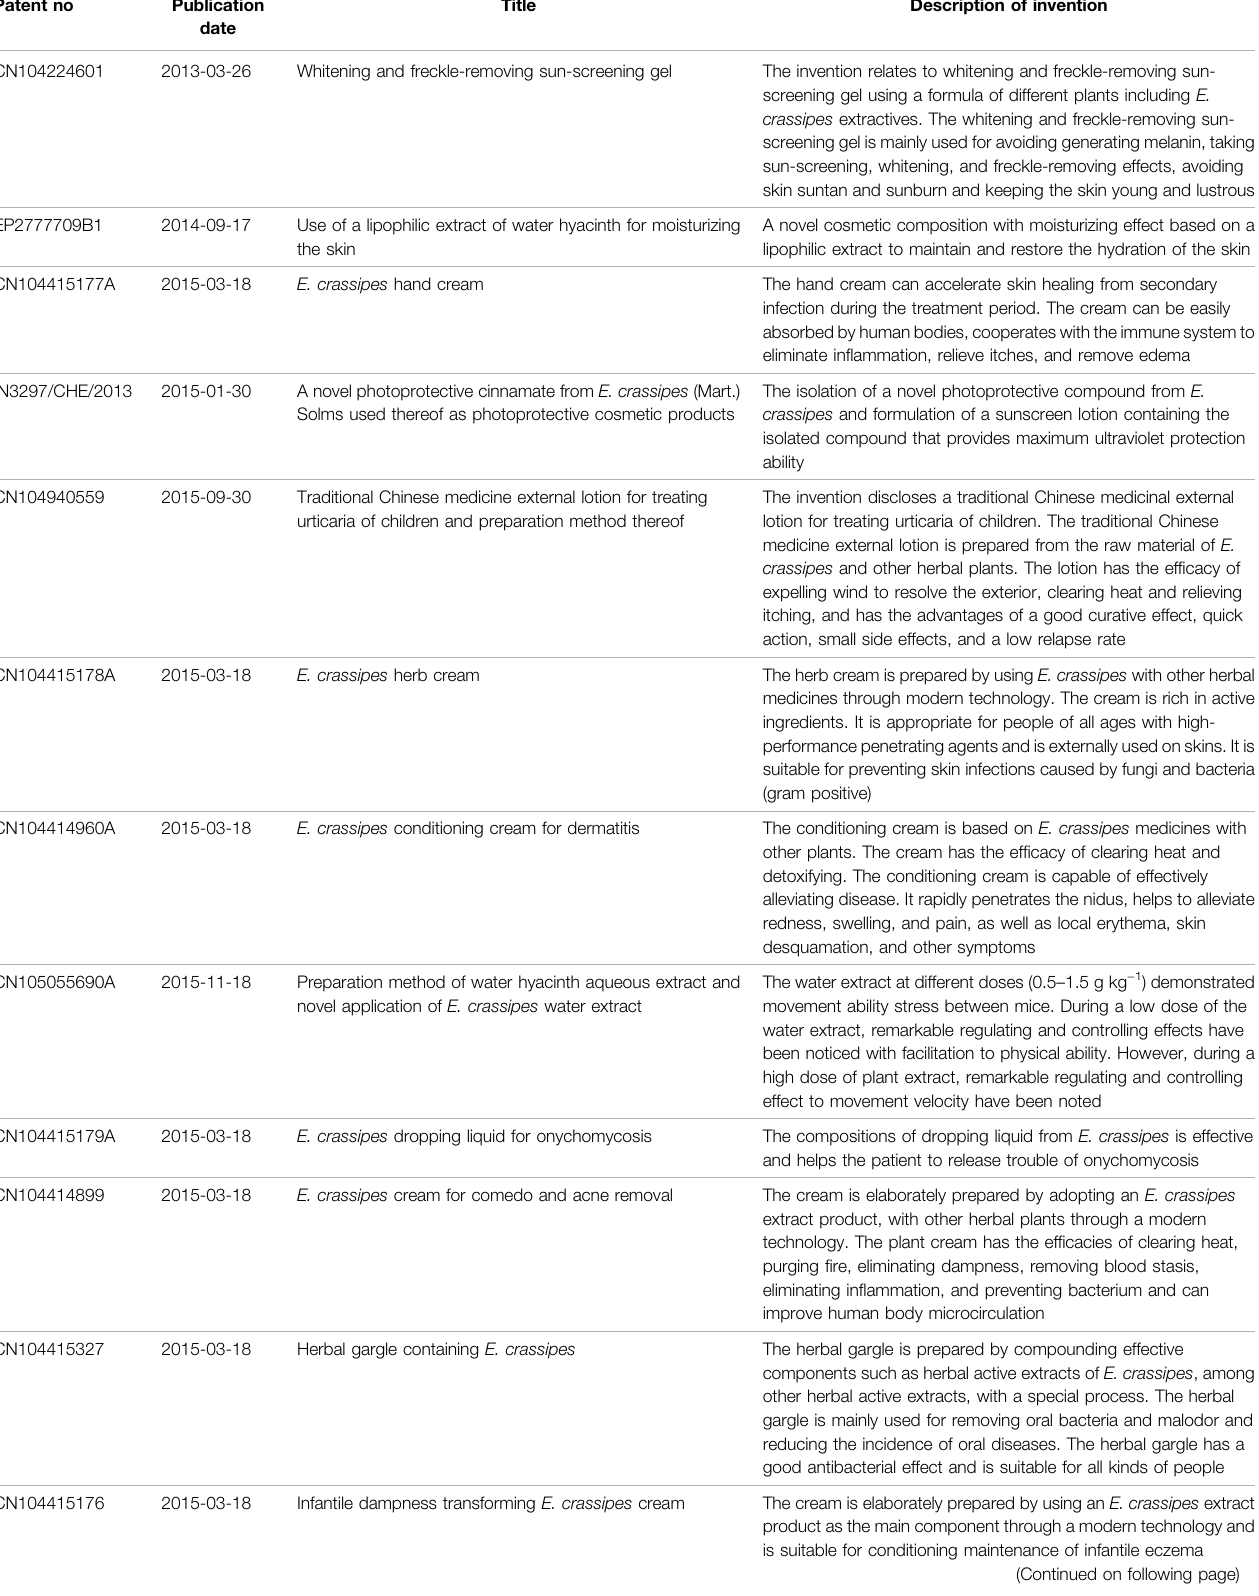
TABLE 5 | Patents related to E. crassipes published between 2010 and